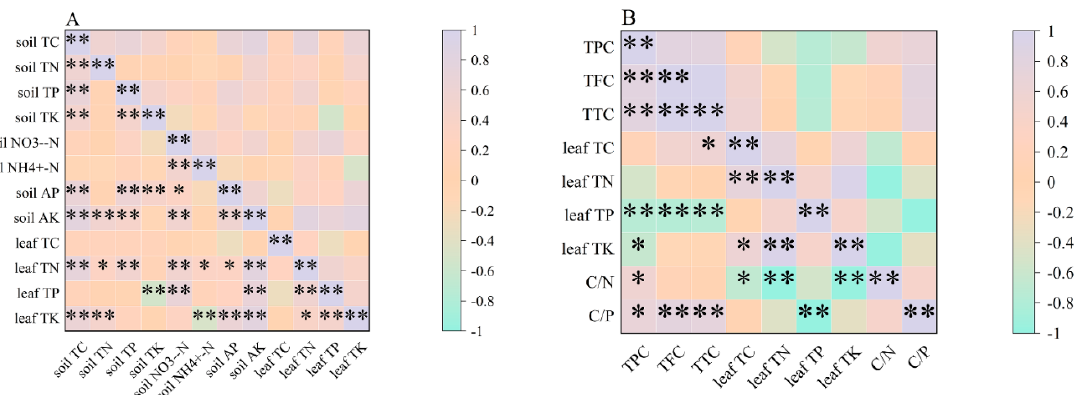
Figure 7. Pearson correlation heatmap between soil nutrient contents and leaf nutrient contents ( A ) as well as between leaf nutrient contents and secondary metabolite contents ( n = 32) ( B ). The * and ** symbols represent significance at 0.05 and 0.01 probability levels, respectively. Abbreviations: TPC: total polyphenol content; TFC: total flavonoid content; TTC: total triterpenoid content.